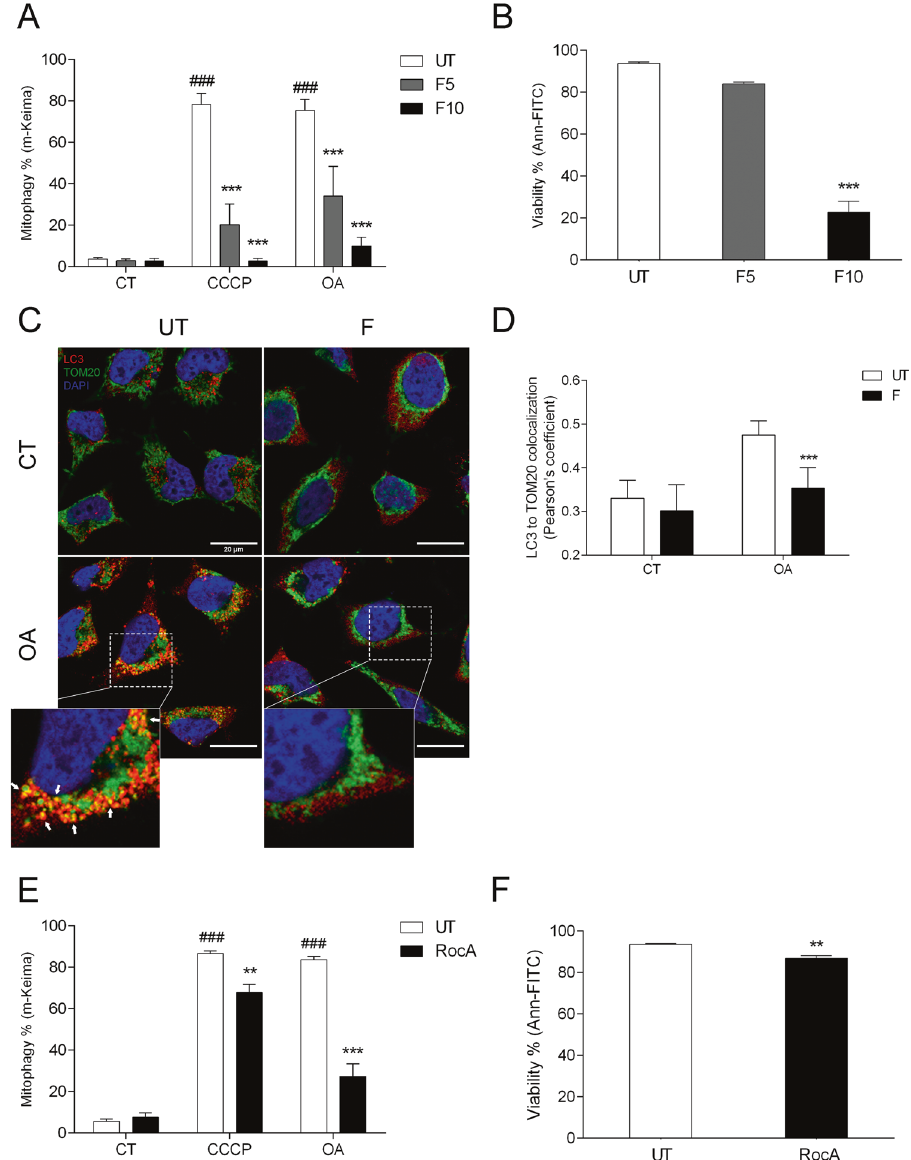
Fig. 1 Fluorizoline inhibits mitophagy in cancer cells overexpressing Parkin. HeLa cells overexpressing Parkin (CT) were treated for 16 h with 10 μ M CCCP or 1 μ M oligomycin/1 μ M antimycin A (OA) in the absence (UT) or presence of 5 or 10 μ M fl uorizoline (F) ( A , B ). HeLa Parkin cells treated with 20 μ M pan-caspase inhibitor Q-VD-OPh and 40 nM ba fi lomycin (CT) were treated for 8 h with 1 μ M oligomycin/1 μ M antimycin (OA), in the absence (UT) or presence of 10 μ M fl uorizoline (F). Cells were co-immunostained for DAPI (blue), TOM20 (green), and LC3 (red) and co-localization was analyzed by confocal microscopy. White arrows indicate the mitochondrial marker within the autophagosome. These are representative images of three independent experiments ( C ). The co-localization between LC3 and TOM20 was measured and is represented as the Pearson ’ s coef fi cient ( n = 3) ( D ). HeLa cells overexpressing Parkin (CT) were treated for 16 h with 10 μ M CCCP or 1 μ M oligomycin/1 μ M antimycin A (OA), in the absence (UT) or presence of 500 nM rocaglamide A (RocA) ( E , F ). m-Keima was measured by fl ow cytometry and it is expressed as the mean ± SEM ( n = 5 independent experiments) of the percentage of mitophagy positive cells ( A , E ). Viability was measured by fl ow cytometry and it is expressed as the mean ± SEM ( n = 4 independent experiments) of the percentage of non-apoptotic cells (annexin V-negative) ( B , F ). ### p < 0.001 CT versus CCCP and OA-treated cells and ** p < 0.01 and *** p < 0.001 UT versus F or RocA-treated